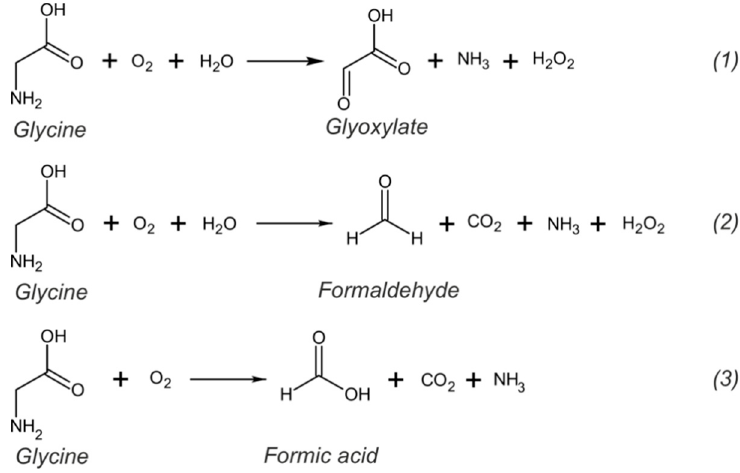
Figure 3. Possible routes for oxidation of glycine.